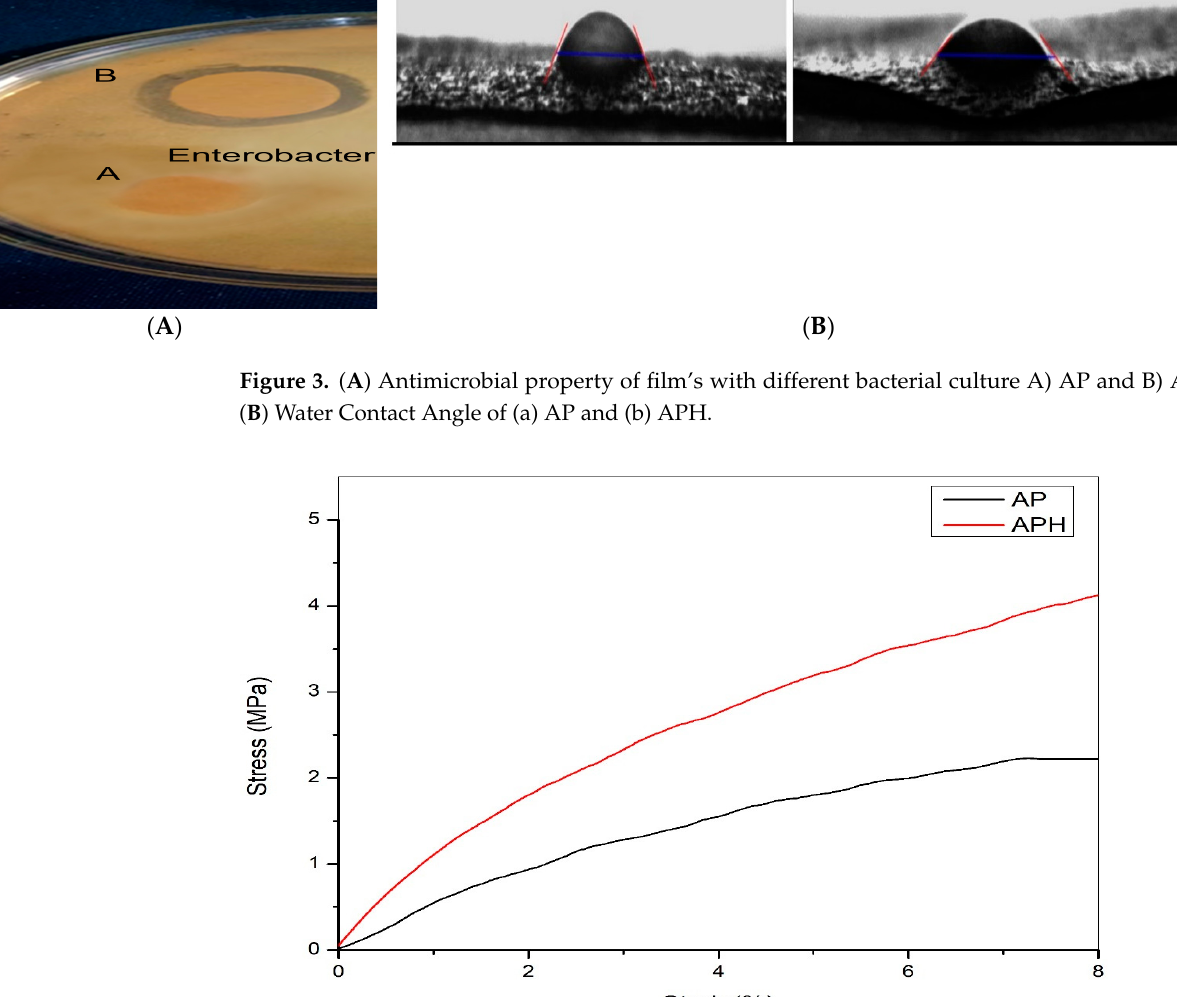
Figure 4. Stress Strain graph of AP and APH film.